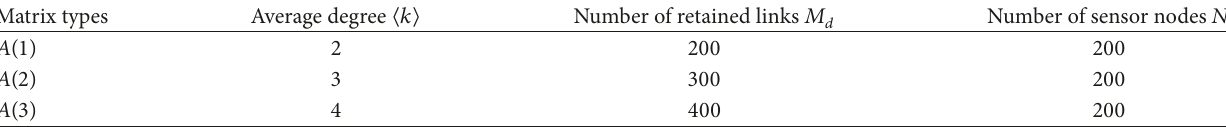
Table 1: Types of matrix 𝐴 for random network and small-world network.